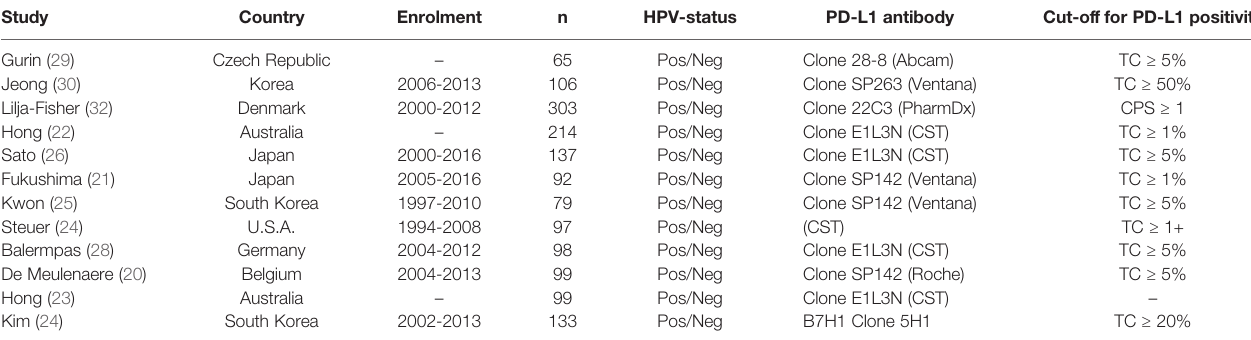
TABLE 1 | Description of included studies.